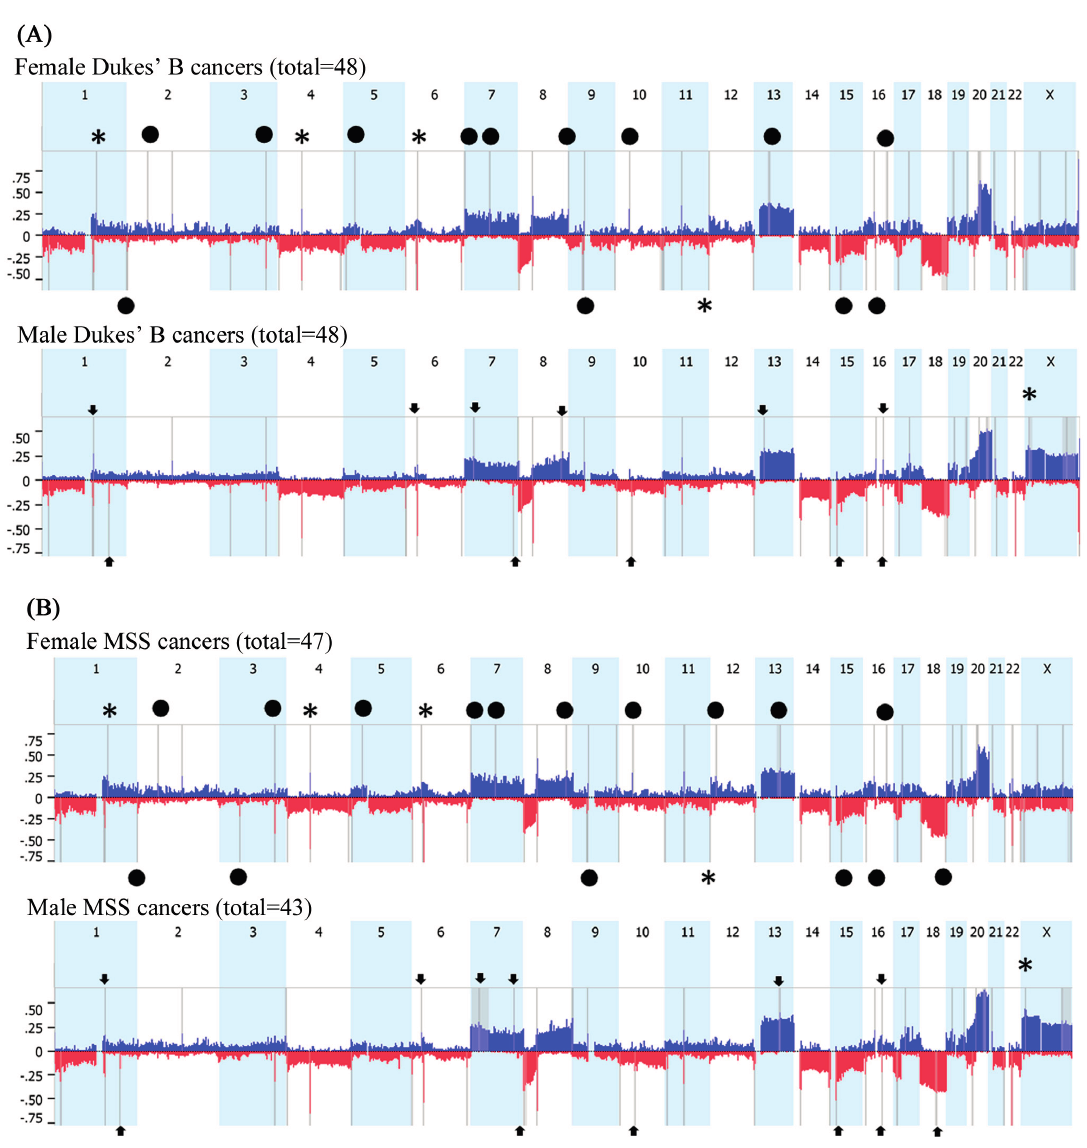
Figure 5. aCGH analysis of the autosomes and the X-chromosome using GISTIC algorithm limited to: ( A ) 96 cases of Dukes’ B cancer; ( B ) 90 cases of MSS cancer; ( C ) 28 cases with sigmoid colon cancer; ( D ) 23 cases with rectal cancer; ( E ) 28 cases with right-sided colon cancer. Gains are depicted in blue and deletions in red. The grey bars indicate highly significant aberrations as detected by GISTIC. Asterisks (*) indicate CNAs previously obtained by STAC then confirmed here. Black circles indicate statistically significant ( p < 0.05) CNA specific to females, while arrowheads pinpoint CNA specific to